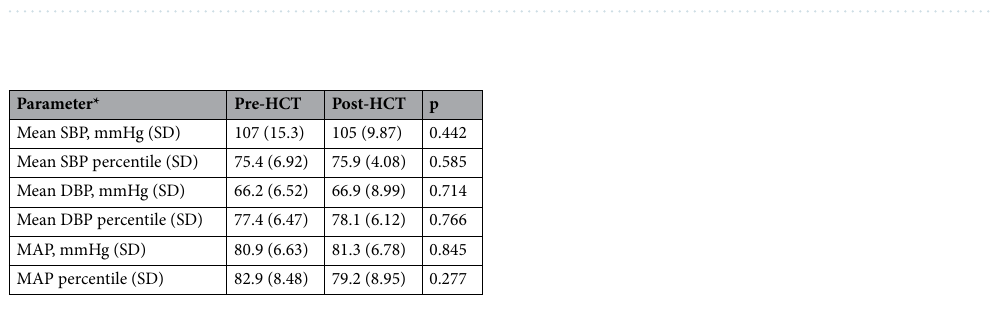
Table 5. ABPM parameters in the pre-HCT group and post-HCT group compared with the obesity control group.